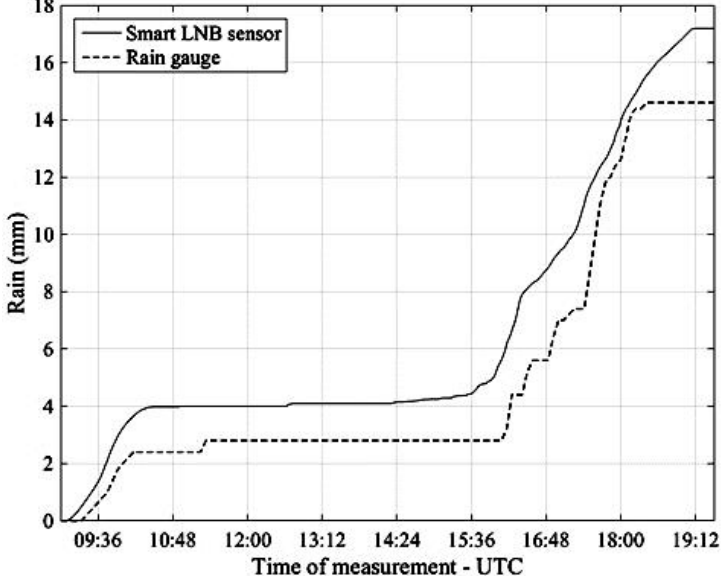
Figure 13. Pisa, 6 May 2017. Accumulated rainfall estimated by the NEFOCAST SmartLNB sensor (solid line) and measured by the TBR (dashed line).